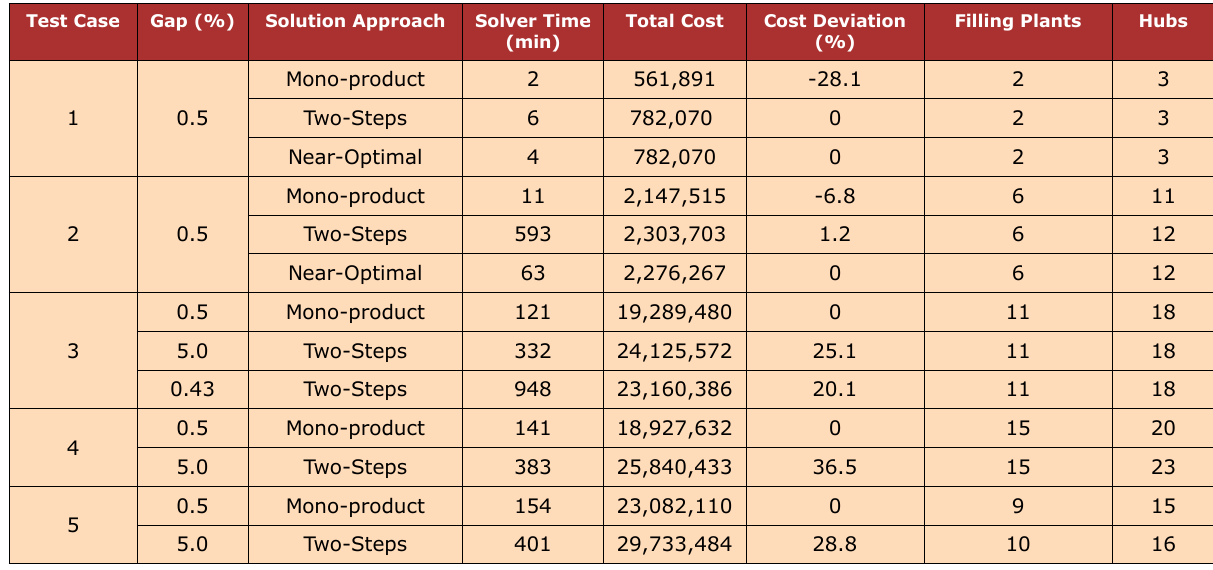
Table 2. Performance Test